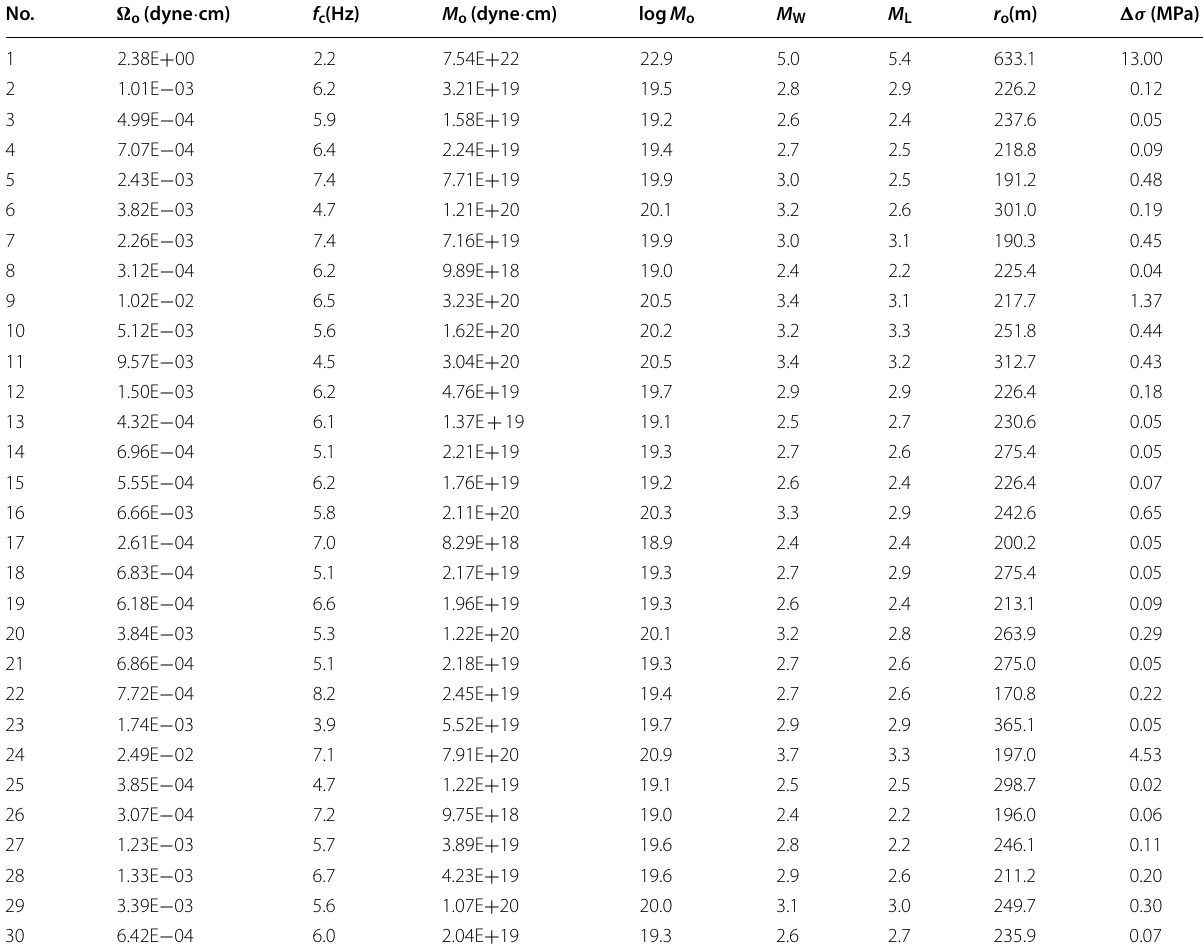
(cid:31) o : relative seismic moment; f c : S-wave corner frequency; M o : absolute seismic moment; M W : moment magnitude; M L : local magnitude; r o : source radius; �σ : stress drop